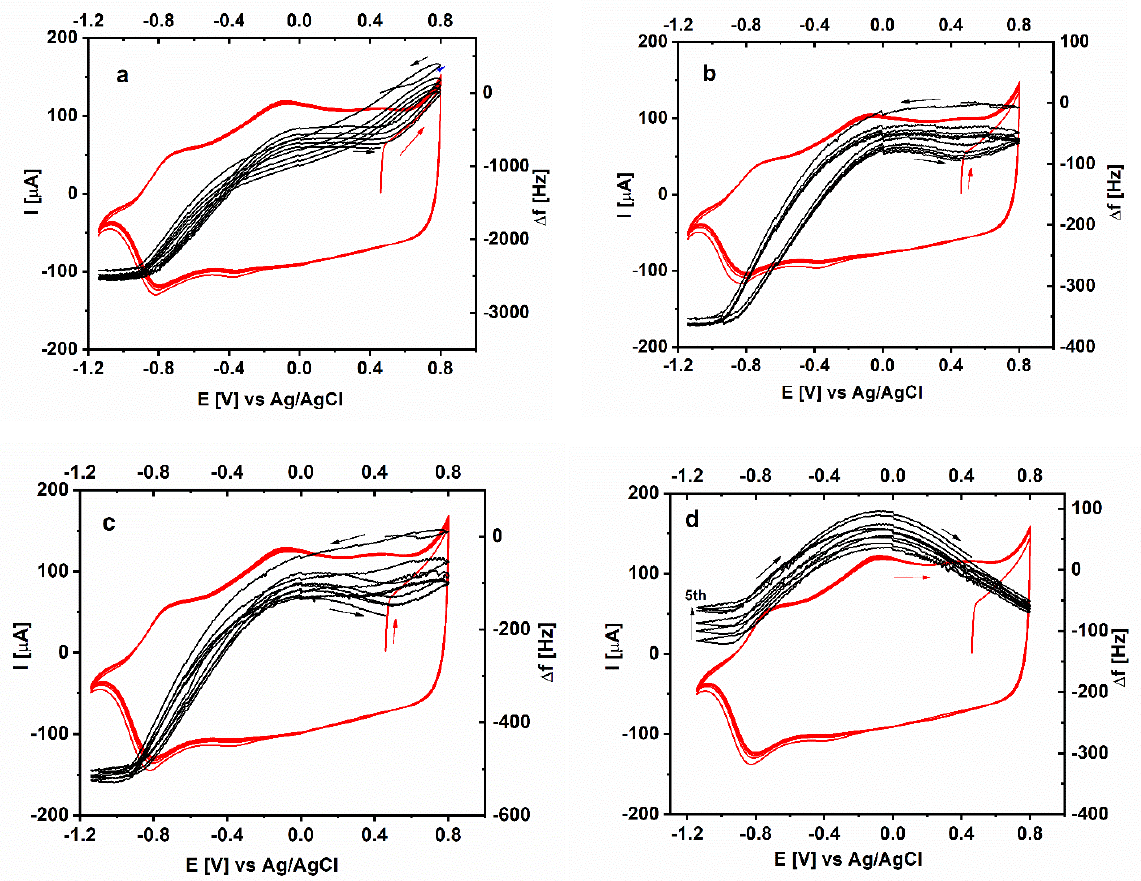
Figure 5. Simultaneous electrochemical (red) and microgravimetric (black) measurements in the course of five voltametric scans in aqueous solution of 0.5 M LiClO 4 for PEDOT films electrodeposited in the presence of: ( a ) PSSA (HMw), ( b ) PSS Na (HMw), ( c ) PSSA (LMw) and ( d ) PSS Na (LMw).